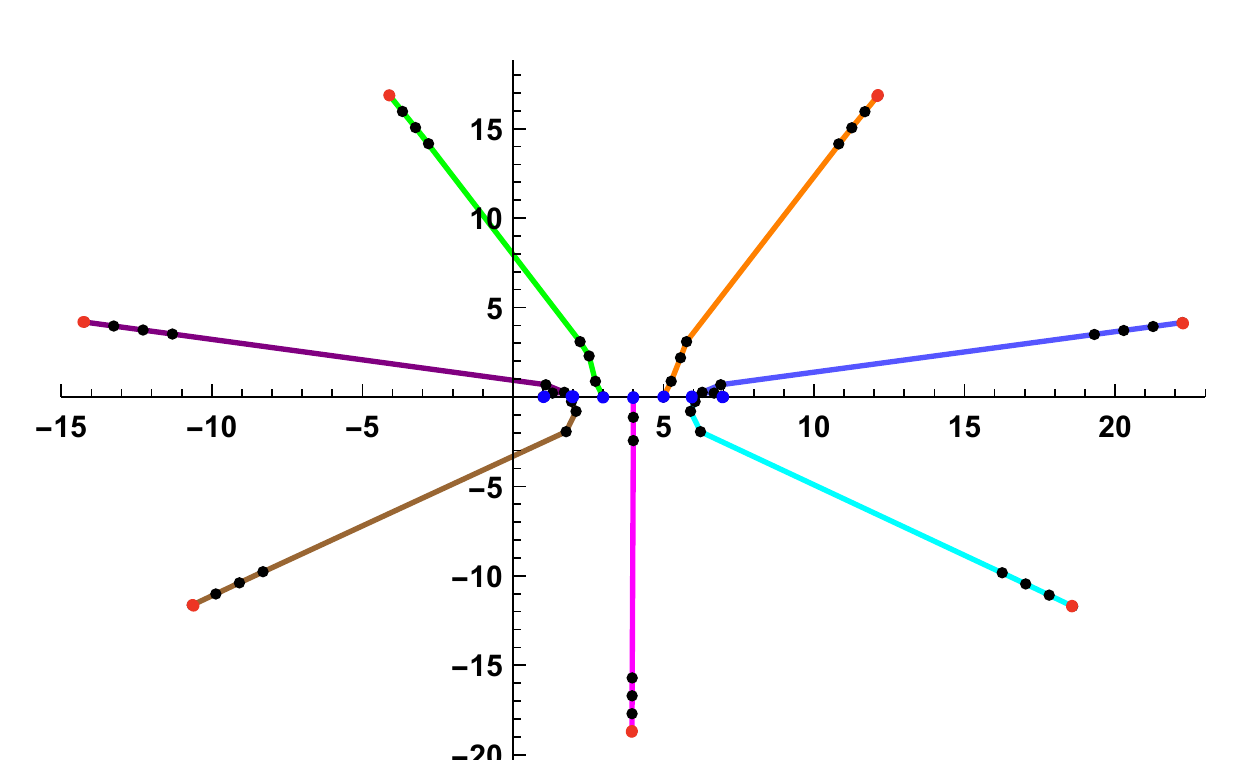
Figure 2. Trajectories of the approximations for Example 2 ( N =